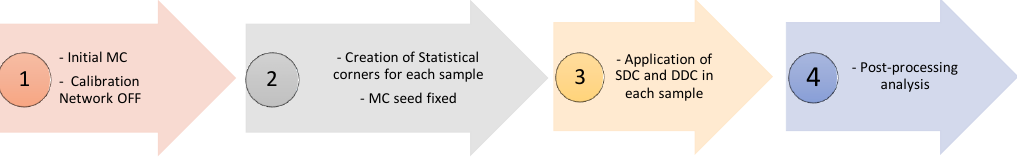
Figure 6. High-level simulation flow adopted in the assessment of SDC and DDC